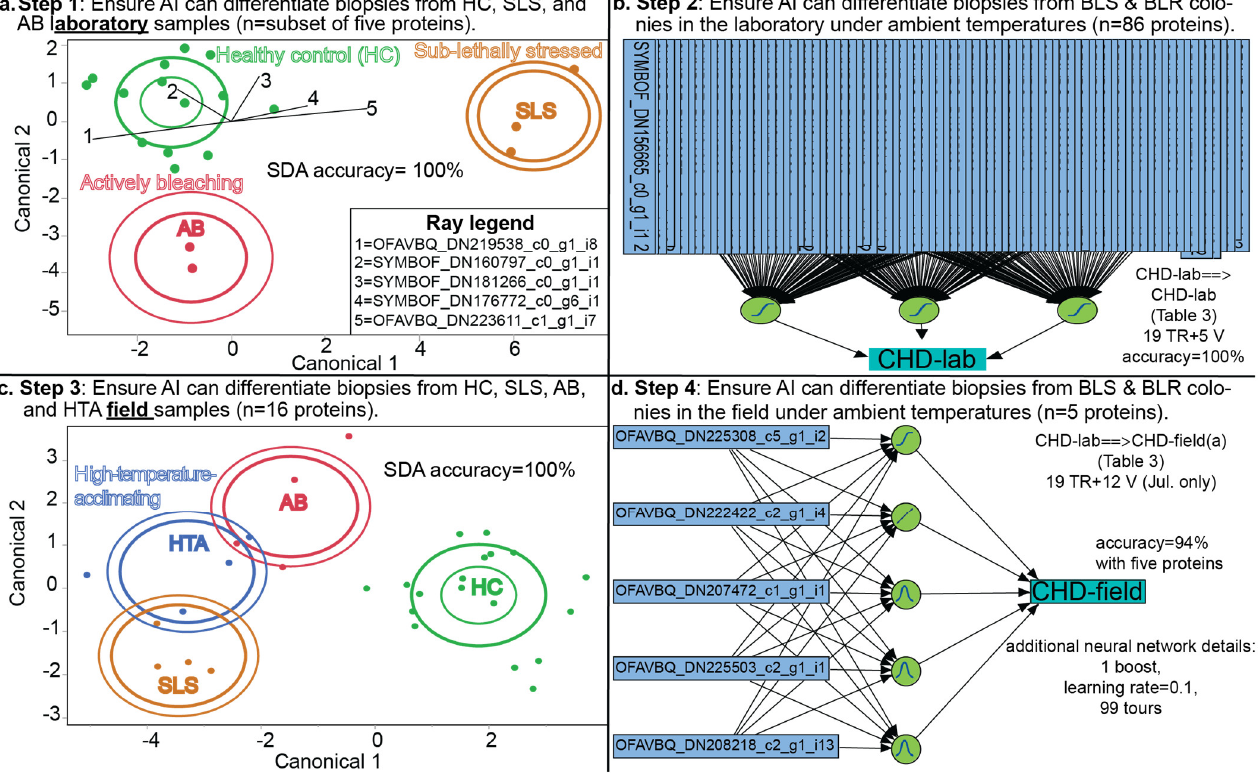
Figure 4. Progressive training of the AI with coral proteomic data. In the stepwise, discriminant analysis (SDA) canonical correlation plots, inner and outer ellipses represent 50 and 95% confidence, respectively, and for the latter, rays are shown only in Supplemental File S2. Note that for step 4, we have shown only one example of the “lab field” approach in which lab-derived protein profiles were used to predict field coral bleaching susceptibility (“CHD-field”); models trained with field data exclusively are instead shown in Table 5. Note that in step 4, a third, intermediately bleaching-susceptible phenotype was considered as a model Y (vs. only bleaching-susceptible [BLS] vs. bleaching-resistant [BLR] as possible colony health designations [CHD] in the lab samples). AB = actively bleaching, HC = healthy control, HTA = high-temperature-acclimating, SLS = sub-lethally stressed.